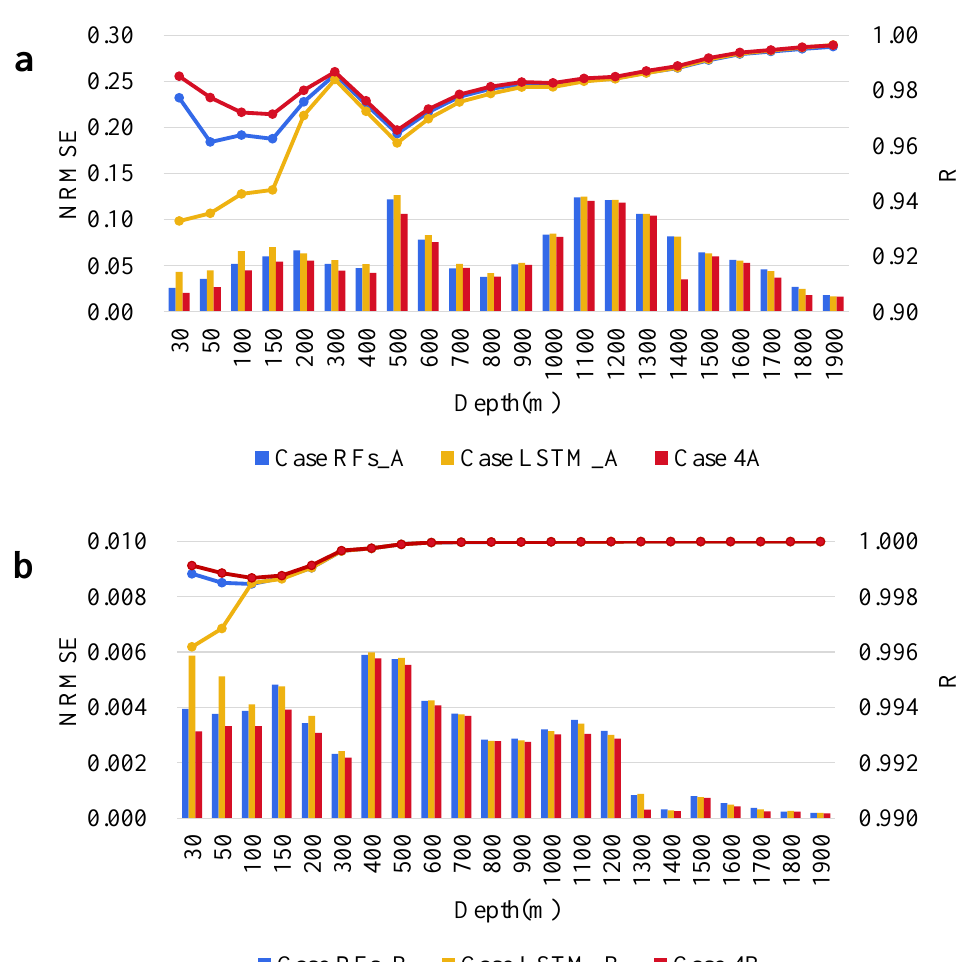
Figure 9. The inversion accuracy of ( a ) ST and ( b ) SS at different depths using RFs, LSTM, and ConvLSTM